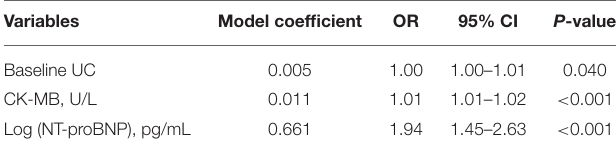
TABLE 3 | Multivariate analysis and the independent predictors in our